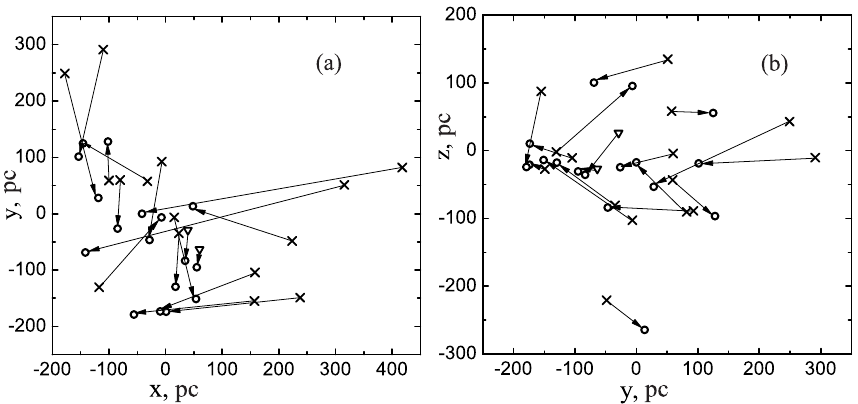
Fig. 2. Motions of the clusters associated with the Local Bubble during its existence, projected on the galactic plane (a) and the plane of galactic rotation (b). The current positions of the clusters are shown by open circles, their positions at the time of the bubble’s origin are marked by oblique crosses, and the locations of the young clusters Feigelson 1 and Mamajek 1 at their birth are shown by triangles. The arrows indicate vectors joining the two positions of the clusters. Feigelson 1 (their present positions are marked by triangles in Fig. 1a,b),